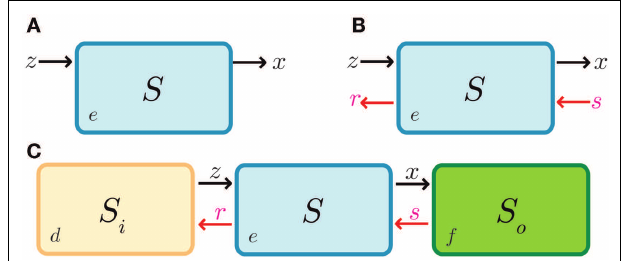
FIGURE 5 | Retroactivity in a box . (A) Symbolic representation of the isolated input–output system as in Del Vecchio et al. (2008) and as an input–output system where retroactivity is neglected. S denotes the system, e is the system’s internal state, z is the input signal received by the module S , and x is the output signal emitted by S (which in this case coincides with the internal state of the system, i.e. , e ). Arrows indicate the signal direction as in Figure 2 (the functionality of S in isolation consists of processing signal z to get signal x ). This figure is equitable to Figure 1A . Here, z would be the input and x the output. (B) Representation of the different signals that may be involved with S as a result of the interconnection; signals r and s correspond to retroactivity to the input and output, respectively. (C) Representation of the embedded system explicitly showing the upstream and downstream modules as well as the interconnection signals ( d and f denote the internal state of system S i and system S 0 , respectively). Here, relative to S 0 , S would be analogous to A in Figure 1 , and S 0 would be equitable to B in Figure 1B